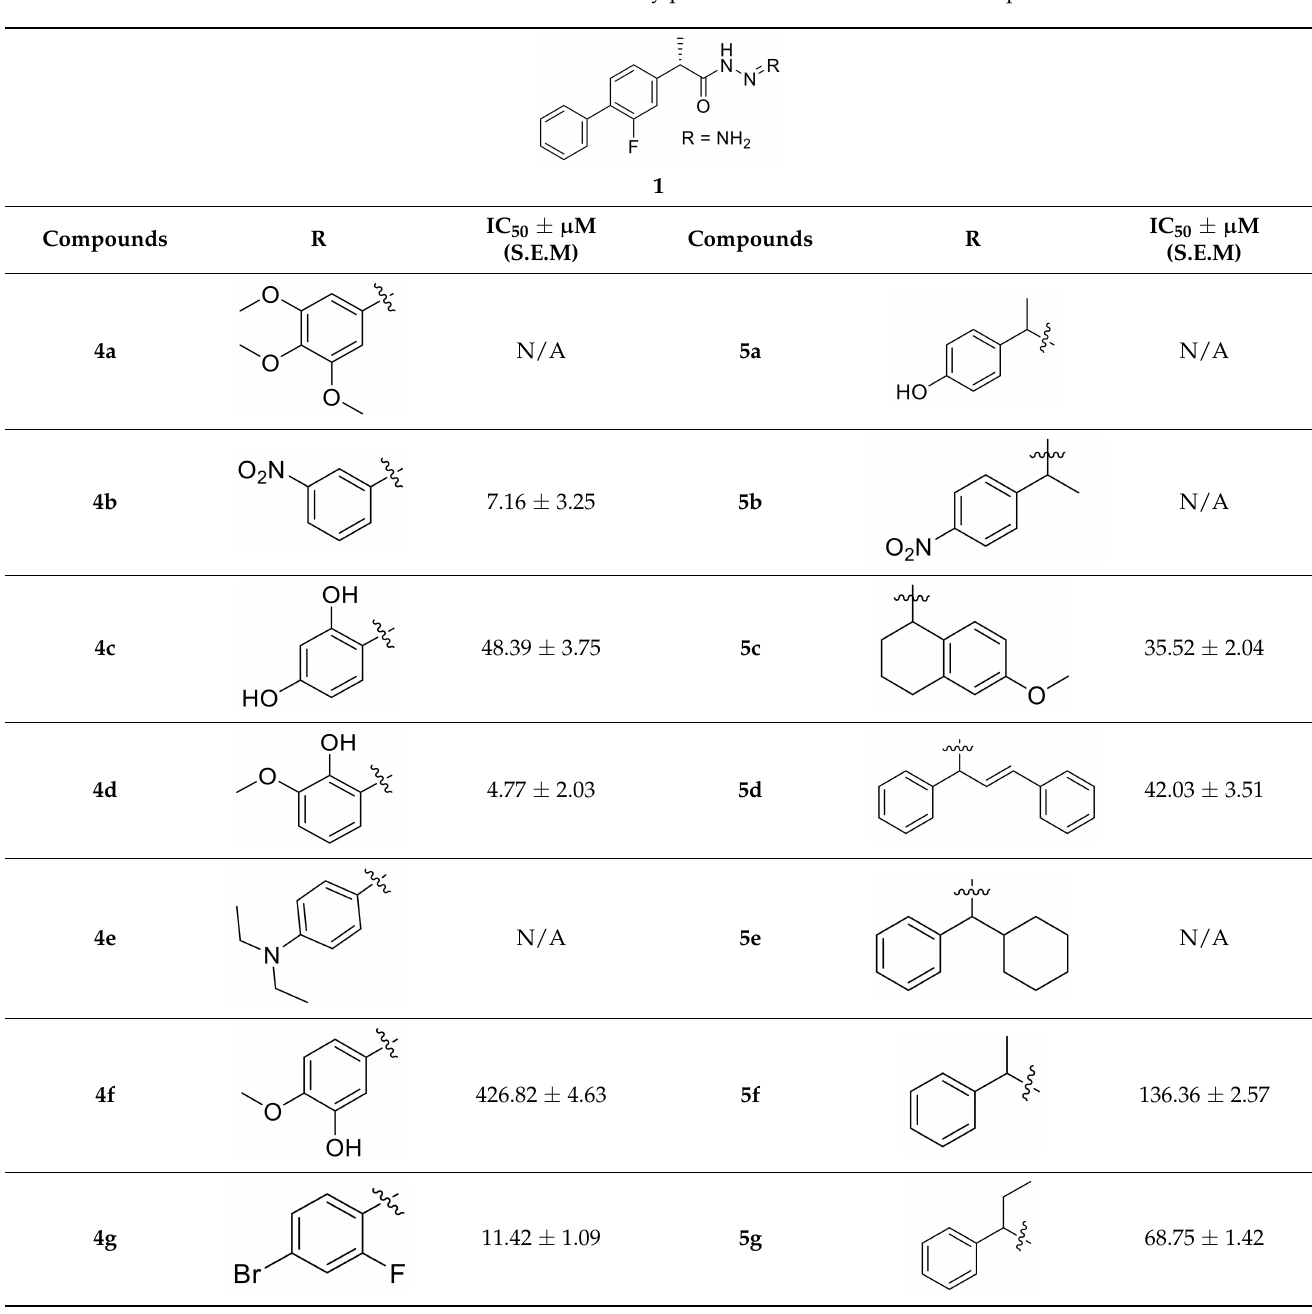
Table 1. α -Glucosidase inhibitory potential of Schiff’s bases of